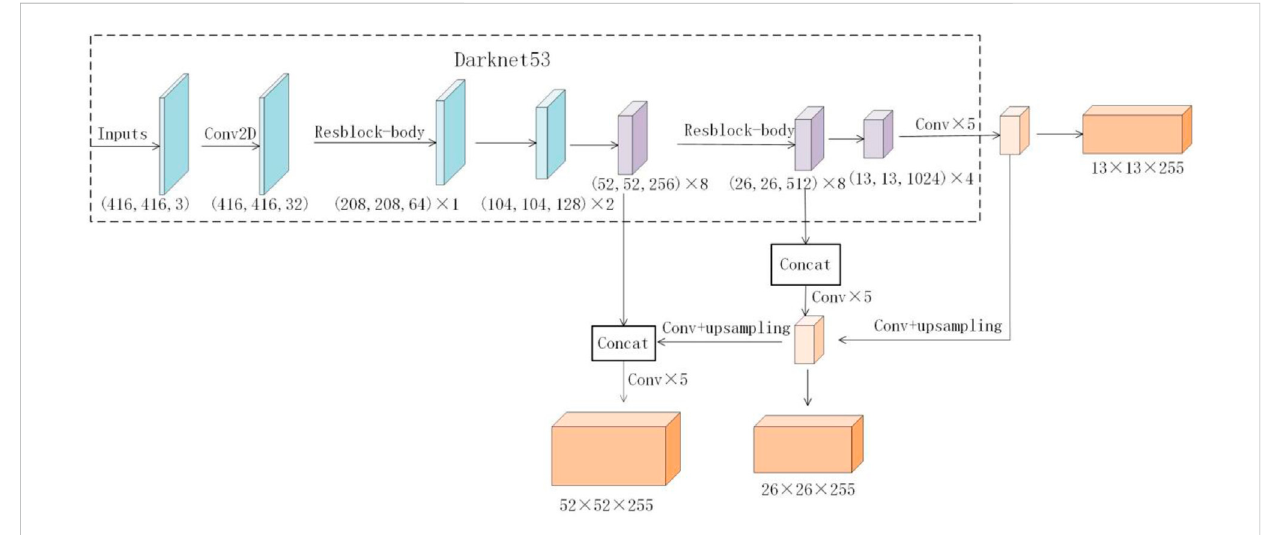
FIGURE 2 Ef fi cientnet-YoloV3 network structure.